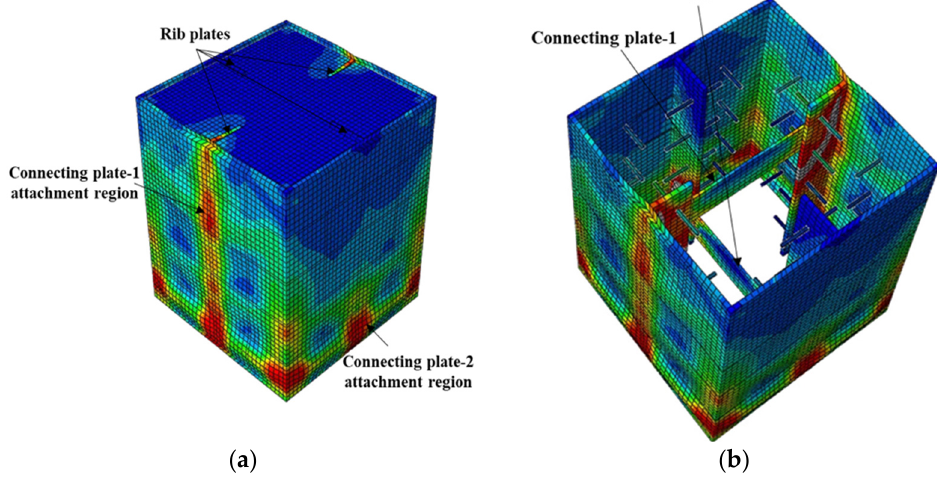
Figure 15. Failure mode of S4-R-Cp (studs, rib plates, and connecting plates): ( a ) stress distribution and ( b ) stress distribution on inner face.